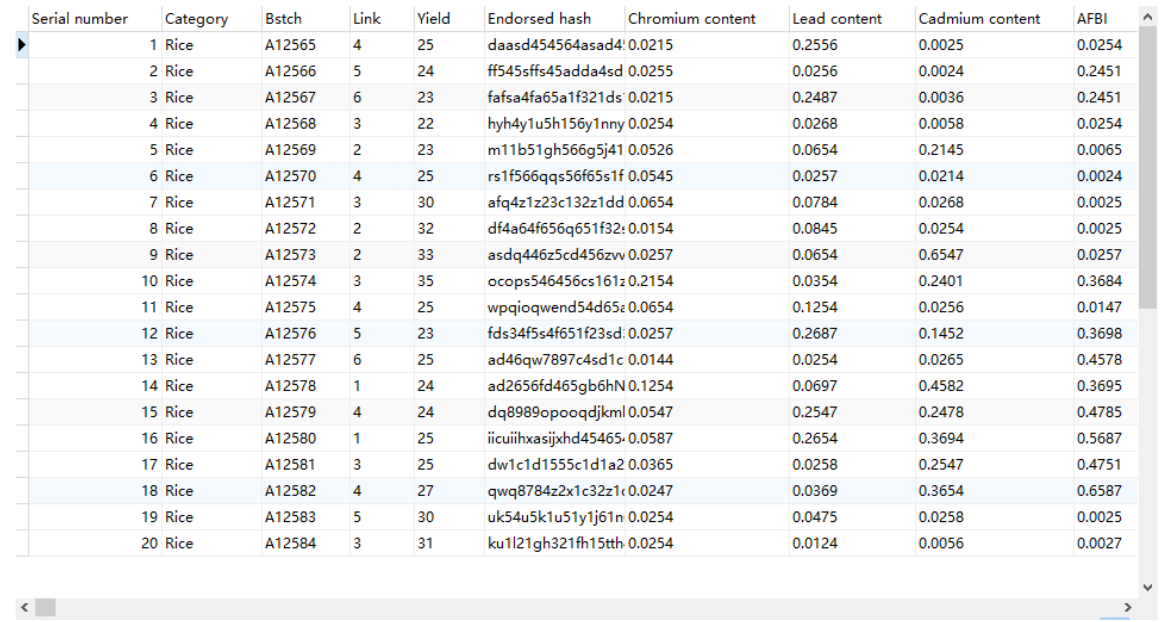
Figure 9. Schematic diagram of data testing.